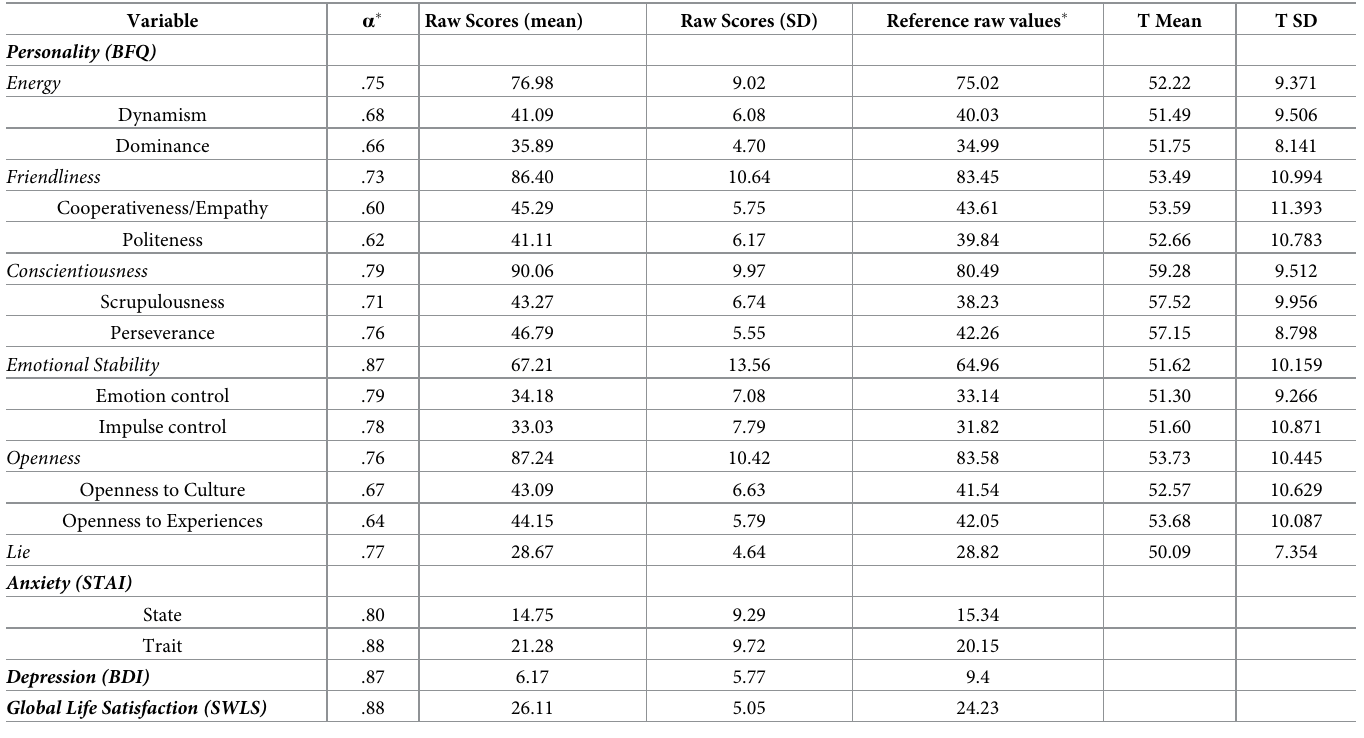
Table 2. Internal consistency, reference values and scores from self-report